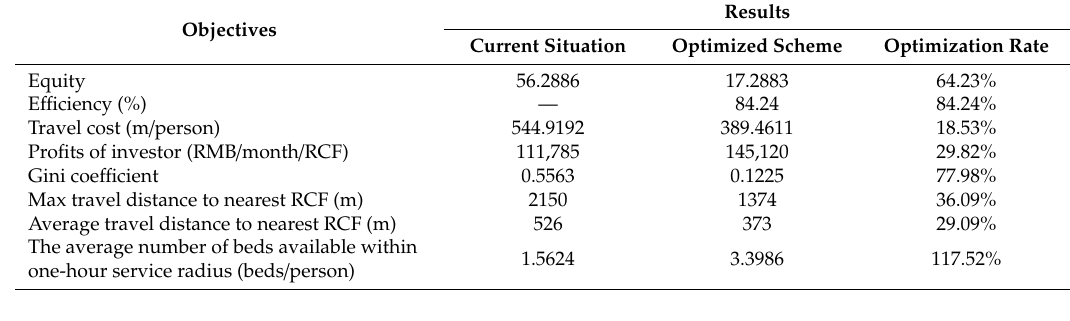
Table 4. Comparison of optimized results with the current situation.